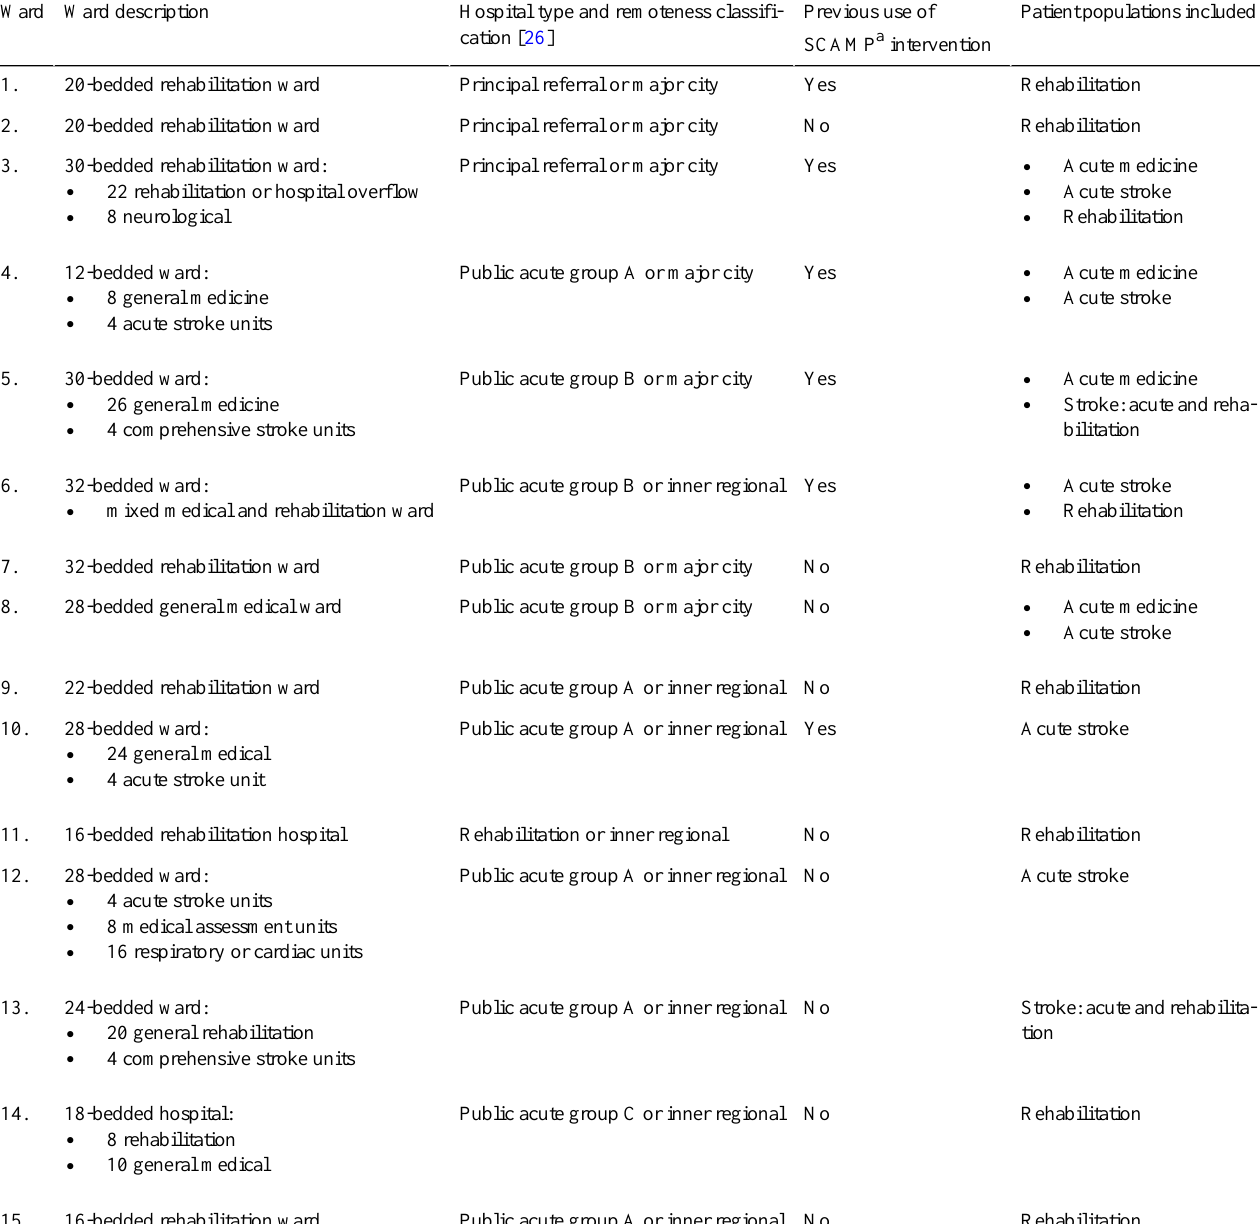
Table 1. Characteristics of the participating wards.